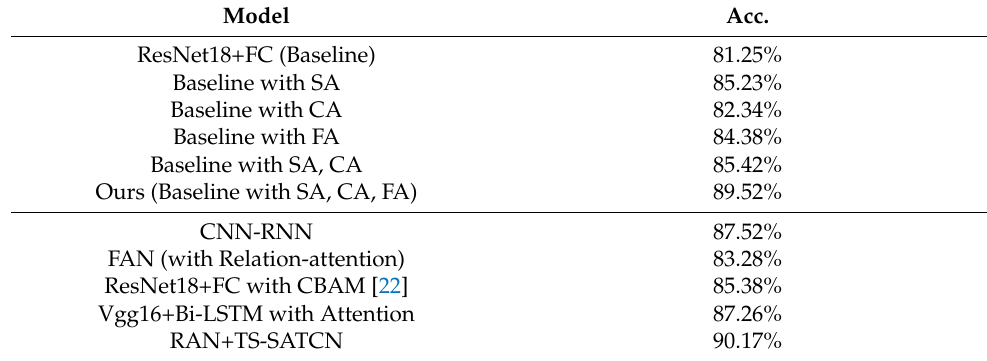
Table 1. Evaluation on the CK+ datasets of the recognition accuracy under different attention modules.